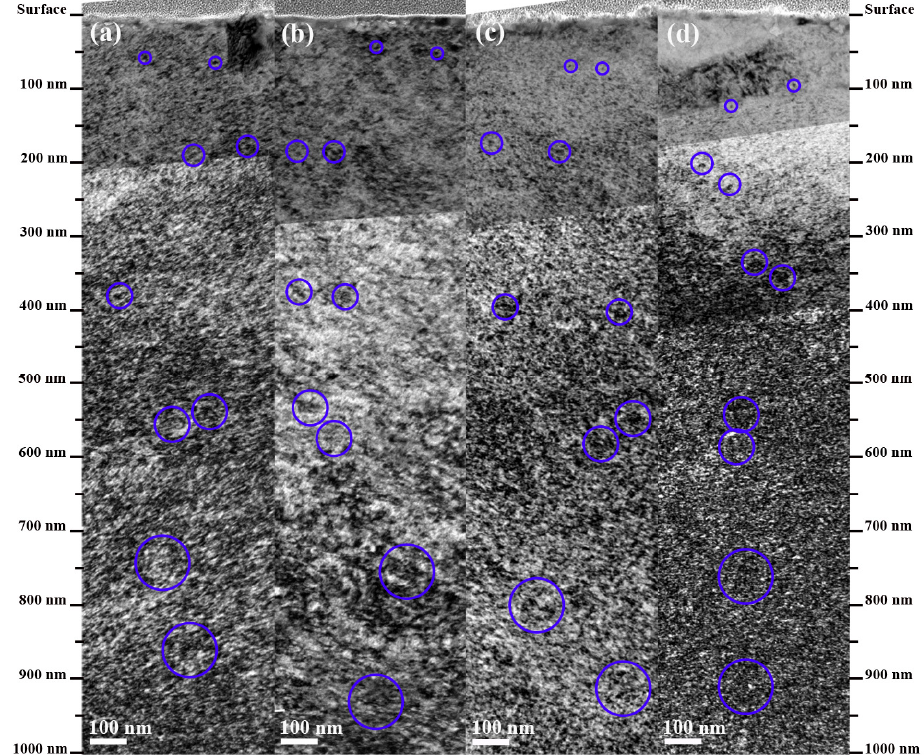
Figure 2. Microstructure of ( a ) S0, ( b ) S1, ( c ) S2, and ( d ) S3 under self-ion irradiation using g = 110 near the pole [001]. (The blue circles represent typical dislocation loops structures.)